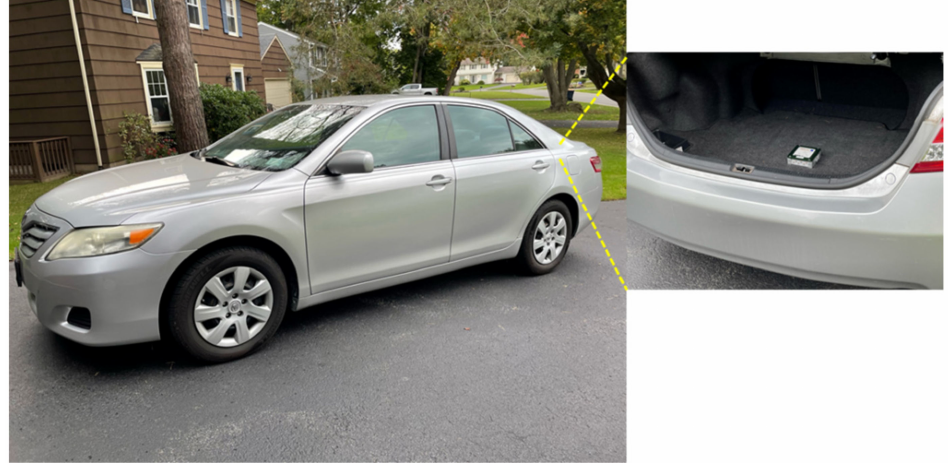
Figure 1. Placement of field data recorder into vehicle cargo